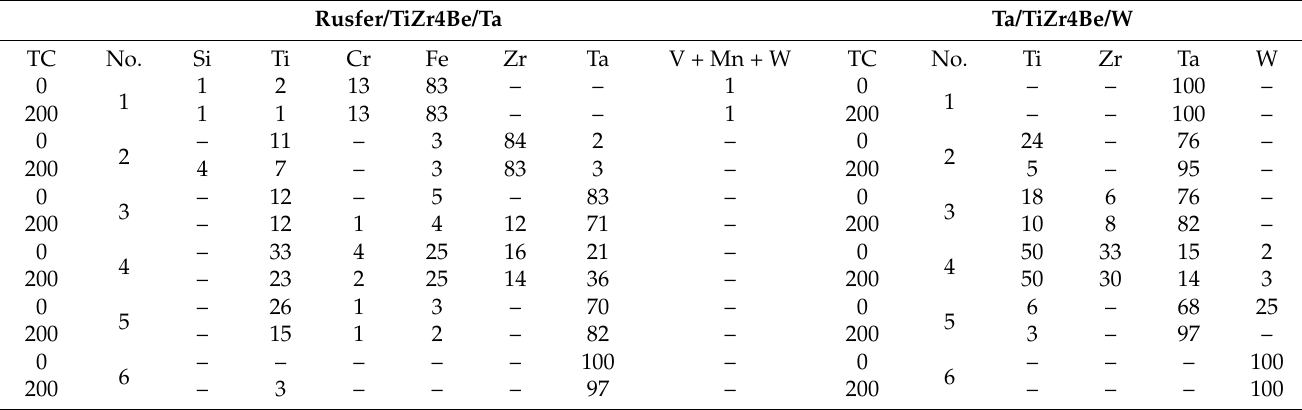
Table 1. EDS analysis of as-joined (0) and thermo-cycled (200) Rusfer/TiZr4Be/Ta/TiZr4Be/W joints, Figures 15 and 16. Rusfer/TiZr4Be/Ta